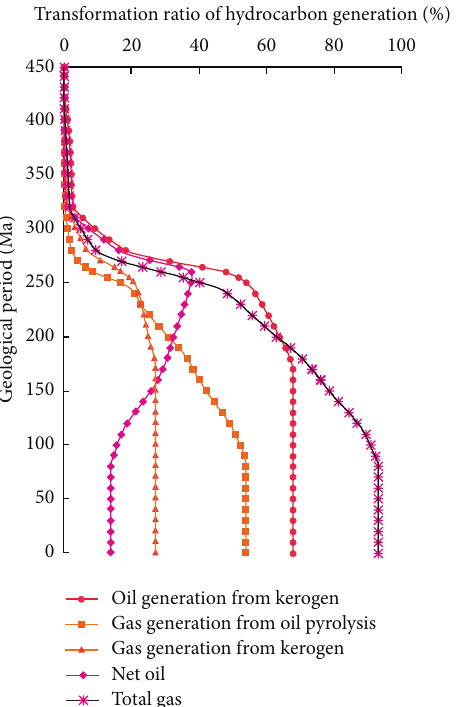
Figure 4: The transformation ratio of hydrocarbon generation with geological period from Py1 well Longmaxi Shale in southeast Chongqing.